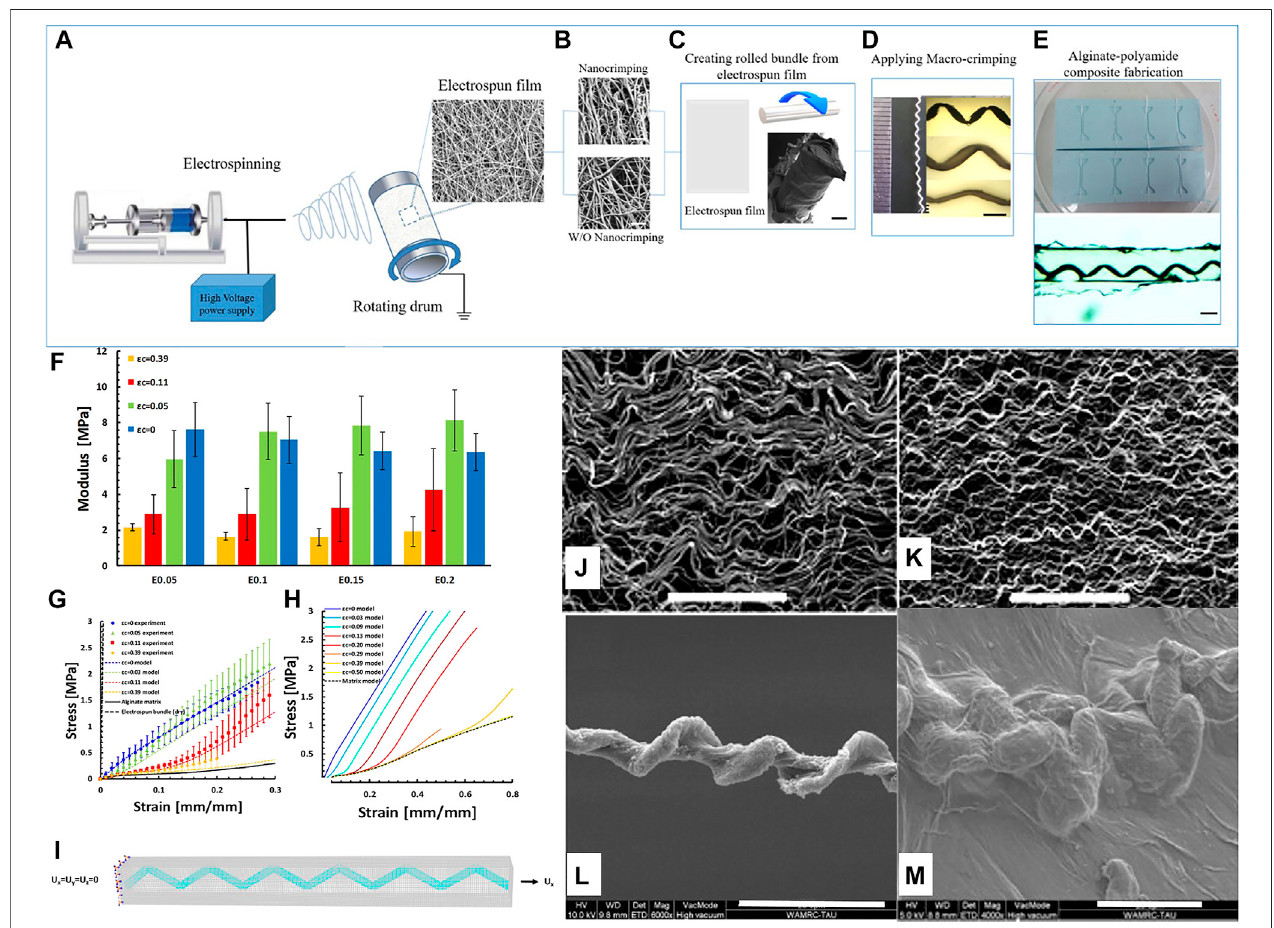
FIGURE 13 | Biomimetics of fi ber and fi bril crimping. (A – I) Hierarchical soft composite fabrication and mechanical behavior. (A) Electrospinning apparatus. (B) Adding nanocrimping to electrospun fi lm. Scale bar 1 µm. (C) Rolling the electrospun fi lm to create a bundle. Scale bar 100 µm. (D) Applying different bundle macro- crimpingangles(75 ° ,127 ° ,and145 ° ,uptobottom).Scalebar1 mm. (E) Alginate-polyamidecompositefabrication.Scalebar1 mm. (F) themodulusofcompositeswith a different crimping angle at 0.05, 0.1, 0.15, and 0.2 strain. (G) Stress-strain curves for composites with different crimping angles under unidirectional tension, experiments vs. FE models. (H) the in fl uence of different crimping angles on the mechanical behavior in FE models of polyamide-alginate composites. (I) polyamide – alginateFEmodelandboundaryconditions.ReprintedfromSharabiandWagner(2021)withpermission. (J , K) SEMimagesofelectrospunP(LLA-AC) fi bers after crimping (scale bar 200 μ m). Reprinted from Chen et al. (2014) with permission. (L , M) Crimping in coral collagen fi bers and collagen-based biocomposites. Scale bar 20 µm. Reprinted from Sharabi et al. (2014) with permission.